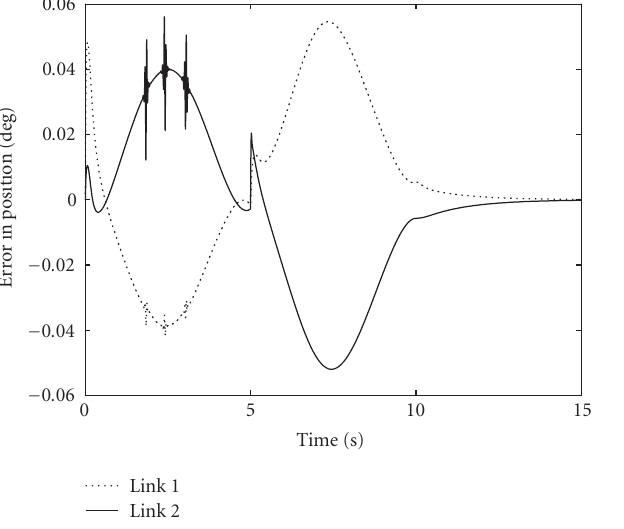
Figure 12: Errors for CDIDC + fuzzy control, trajectory 1.